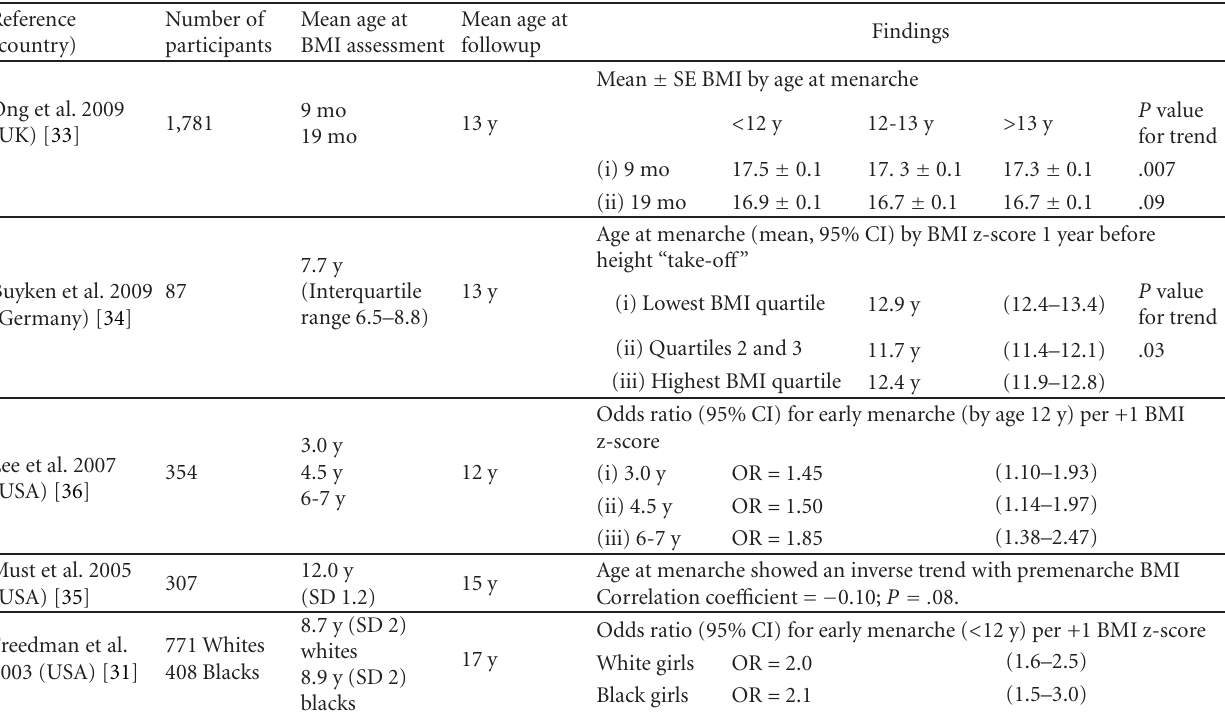
Table 3: Longitudinal studies reporting the association between childhood BMI and subsequent age at